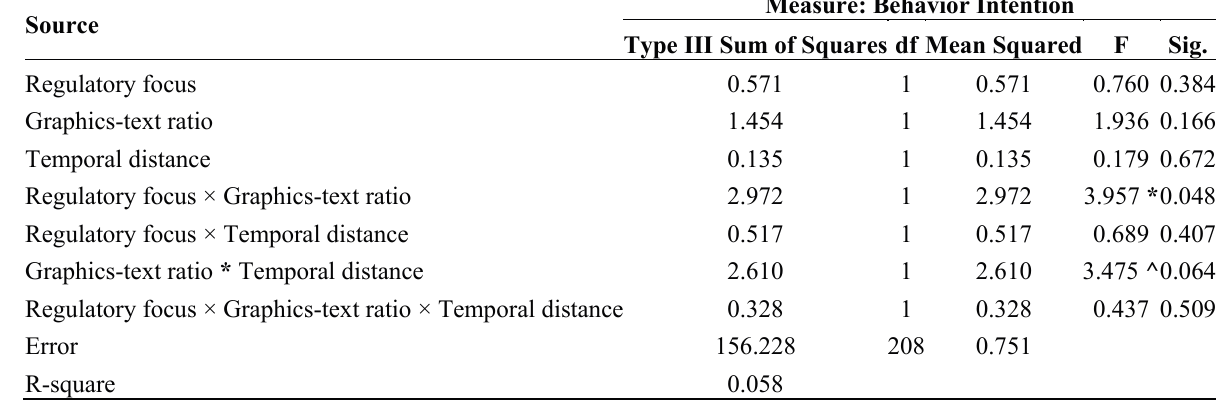
Table 5. Tests of between-subject effects for behavior